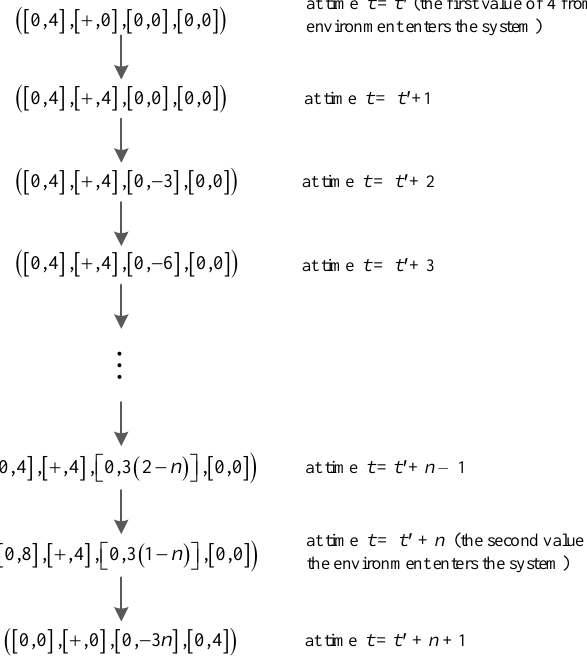
Figure 7. Configuration dynamics of the INPUT module.